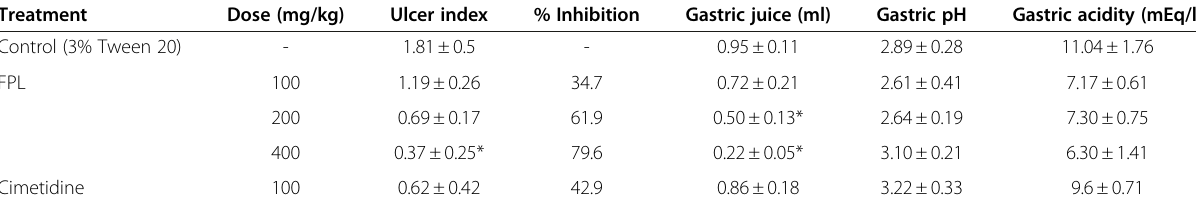
Table 3 Effect of FPL extract on pylorus ligation induced gastric ulcers Treatment Dose (mg/kg) Ulcer index % Inhibition Gastric juice (ml) Gastric